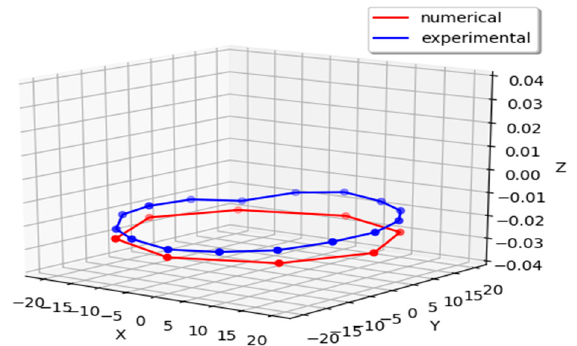
Figure 12. Comparison between numerical and experimental deformations on the inner circle.